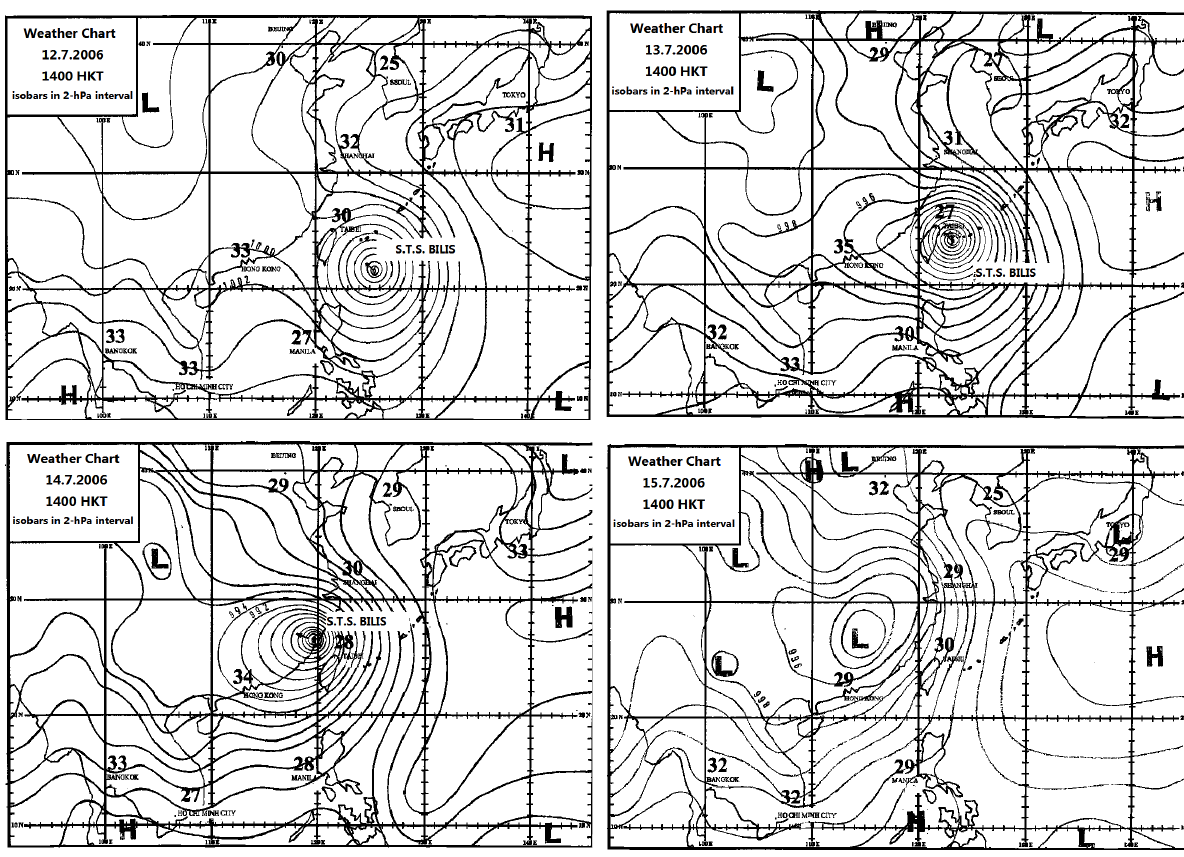
Fig. 3. Surface weather conditions on 12–15 July 2006. Table 1. Statistical parameters between the measured 2m air temperature ( T ), wind speed (WS), and wind direction (WD) and the